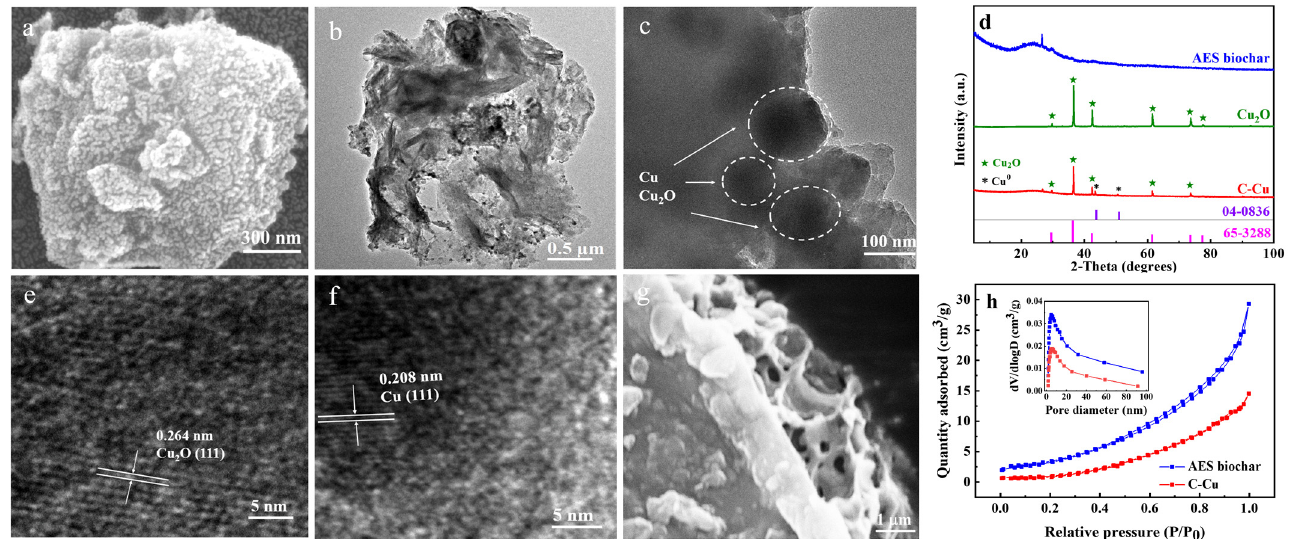
Figure 1. ( a ) SEM image and TEM images of C ‐ Cu at ( b ) 0.5 μ m and ( c ) 100 nm. (d) XRD patterns of AES biochar, Cu 2 O, and C ‐ Cu. HR ‐ TEM images of C ‐ Cu with ( e ) Cu 2 O and ( f ) Cu 0 planes. ( g ) SEM of AES biochar, Cu 2 O, and C-Cu. HR-TEM images of C-Cu with ( e ) Cu 2 O and ( f ) Cu 0 planes. image of AES biochar. ( h ) N 2 sorption isotherms of C ‐ Cu and AES biochar. Inset: Pore size ( g ) SEM image of AES biochar. ( h ) N 2 sorption isotherms of C-Cu and AES biochar. Inset: Pore distribution. size